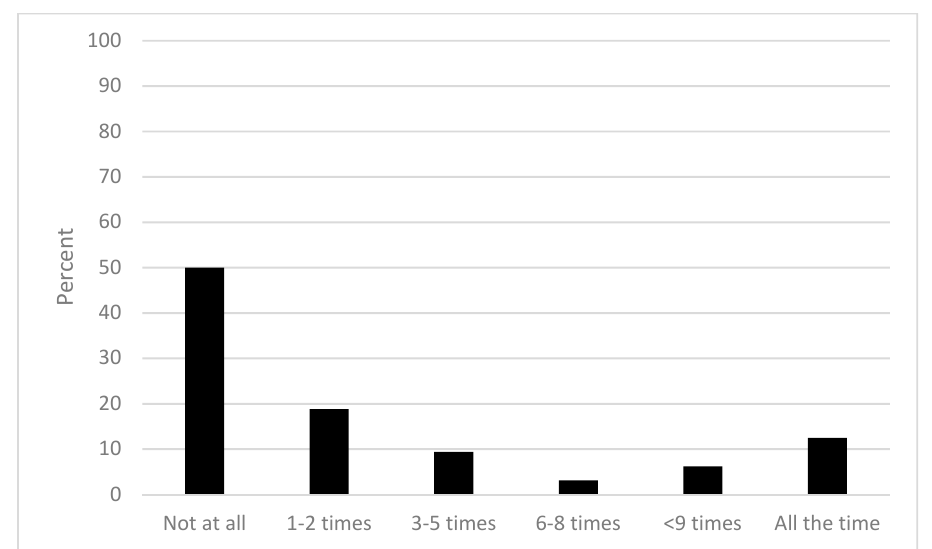
Figure 4. Participants travel by public transport (PT) in the last two weeks.